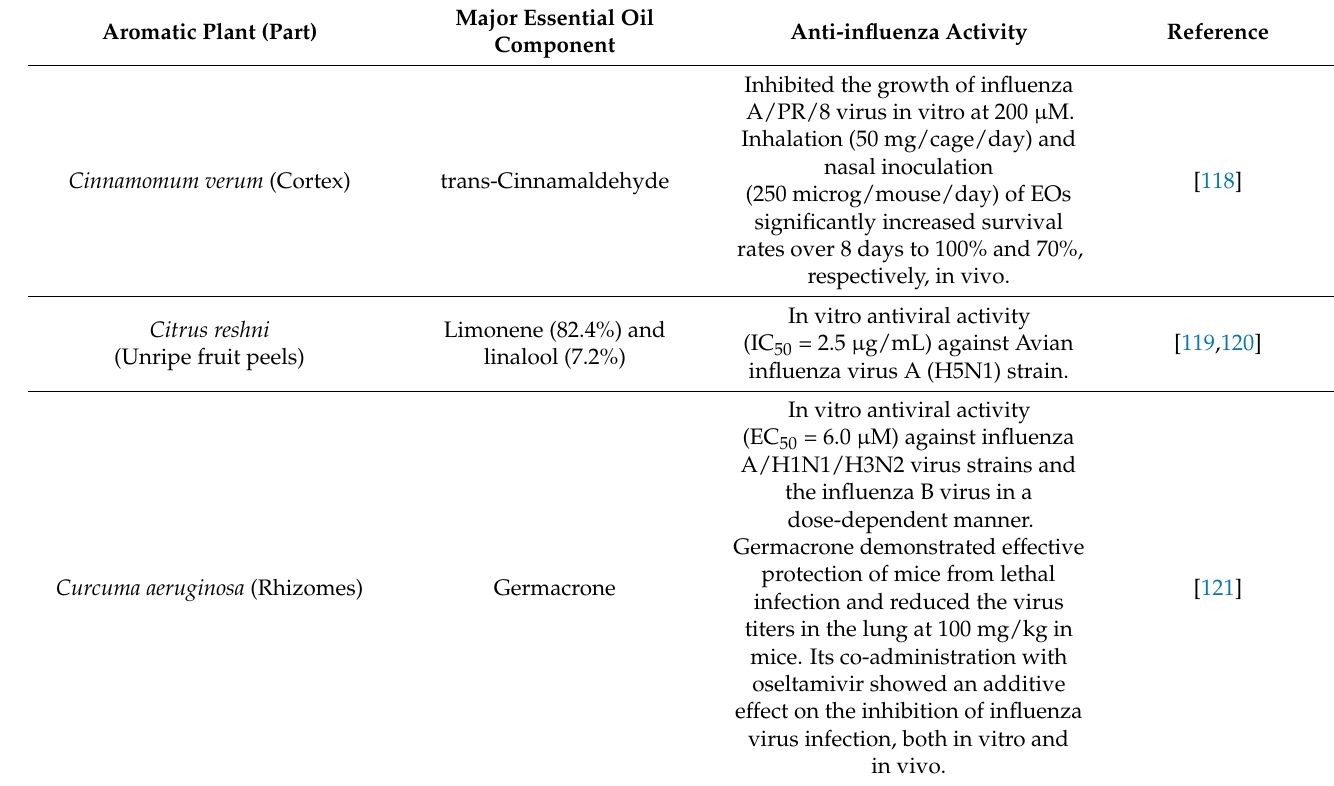
Table 2. Some plant-derived essential oil compounds and their anti-influenza